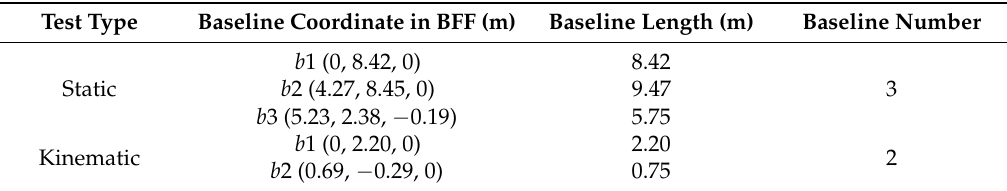
Table 1. GNSS baseline configuration in static and kinematic experiments.